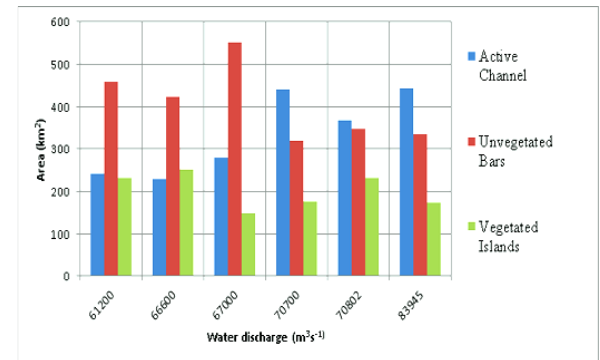
Figure 5. Bar dynamics with discharge